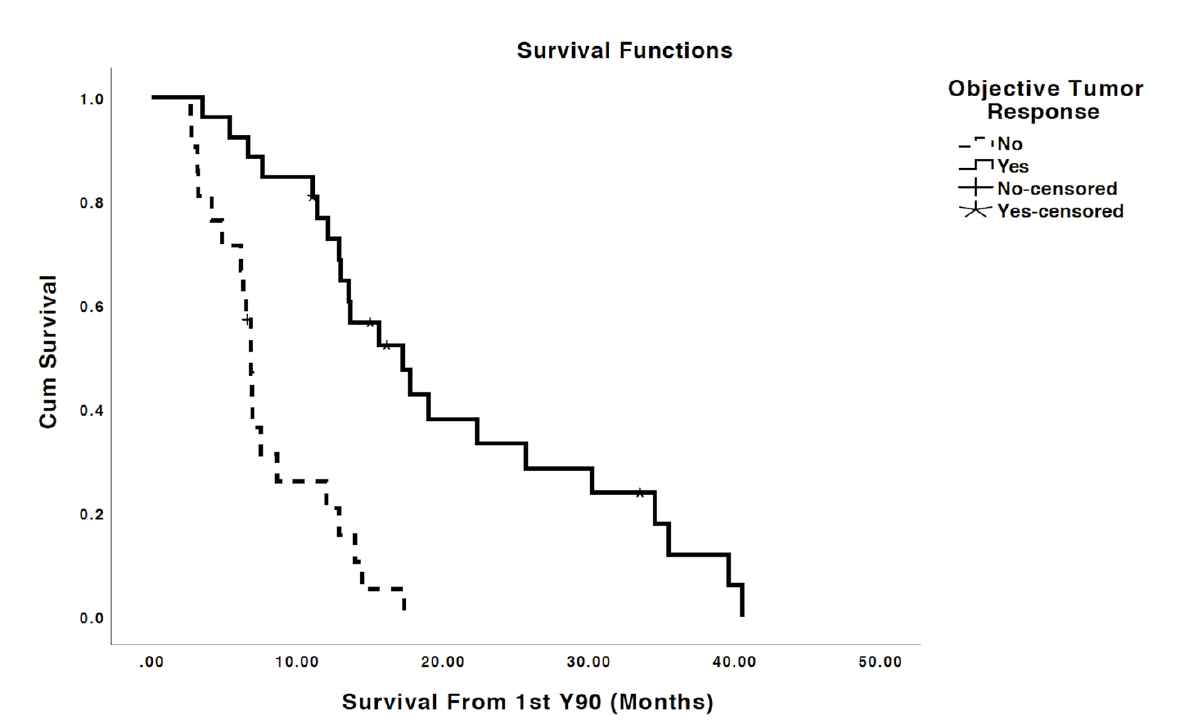
Figure 1. Patients exhibiting objective response had a median OS of 17.2 months vs 6.8 months for those without OR ( p < 0.001).